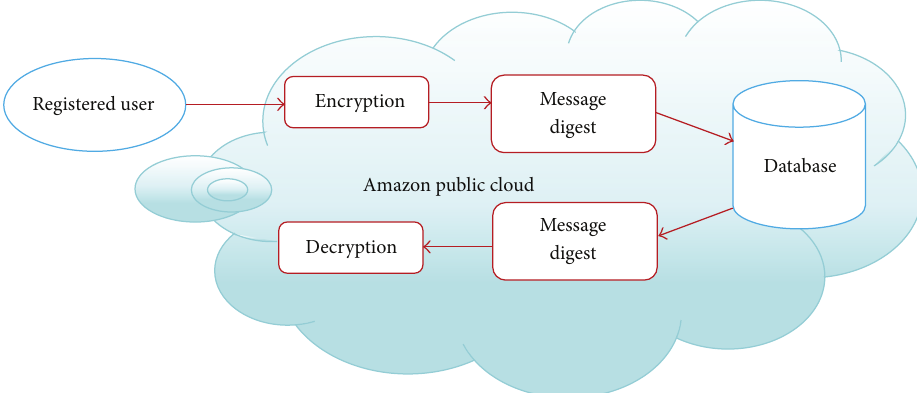
Figure 1: Proposed architecture.